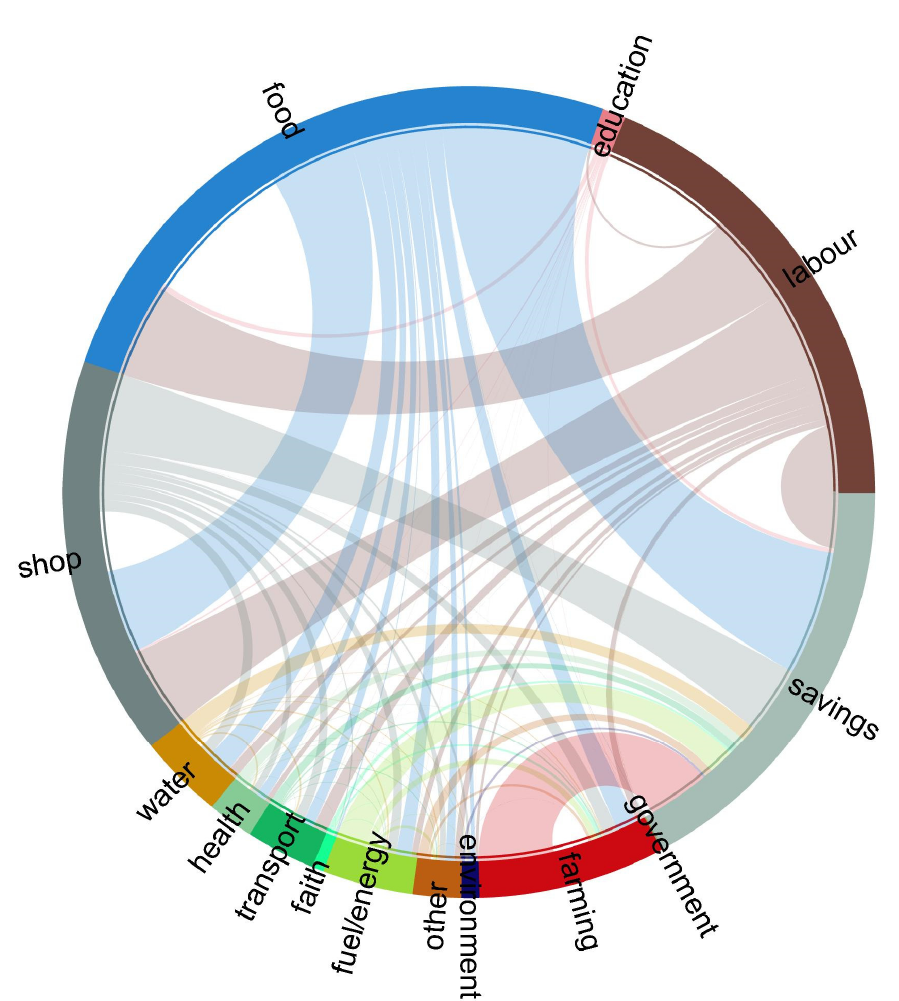
Figure 11. Purchases of Seller and Buyer Business-Types, Weighted by Trade Values. All Financial Transactions are Removed Except “Savings” with Chamas. Two-way transfers such as between food vendors purchasing labor, and labor purchasing food, are consolidated as one link.